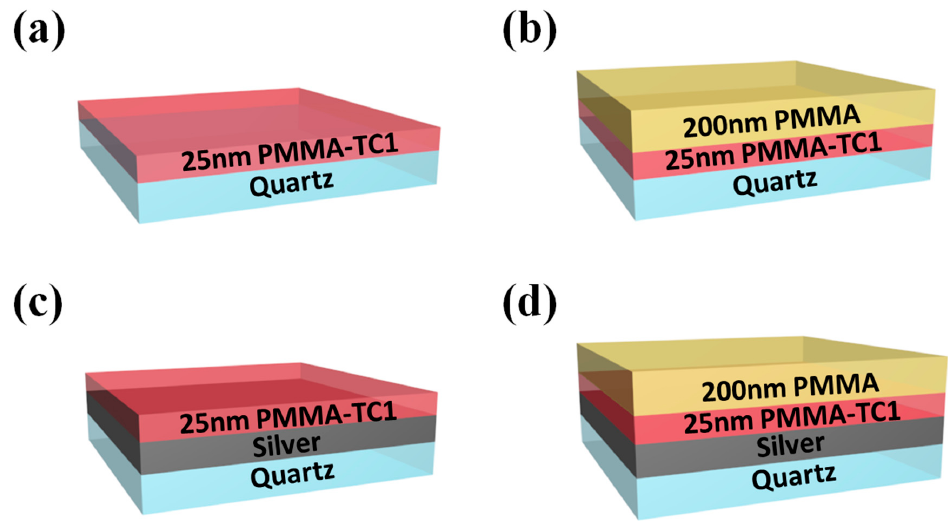
Figure 1. The schematic diagram of four structures of TC1-labeled PMMA denoting as ( a ) structure-A (quartz/PMMA-TC1), ( b ) structure-B (quartz/PMMA-TC1/bulk layer), ( c ) structure-C (quartz/Ag/PMMA-TC1), and ( d ) structure-D (quartz/Ag/PMMA-TC1/bulk layer).